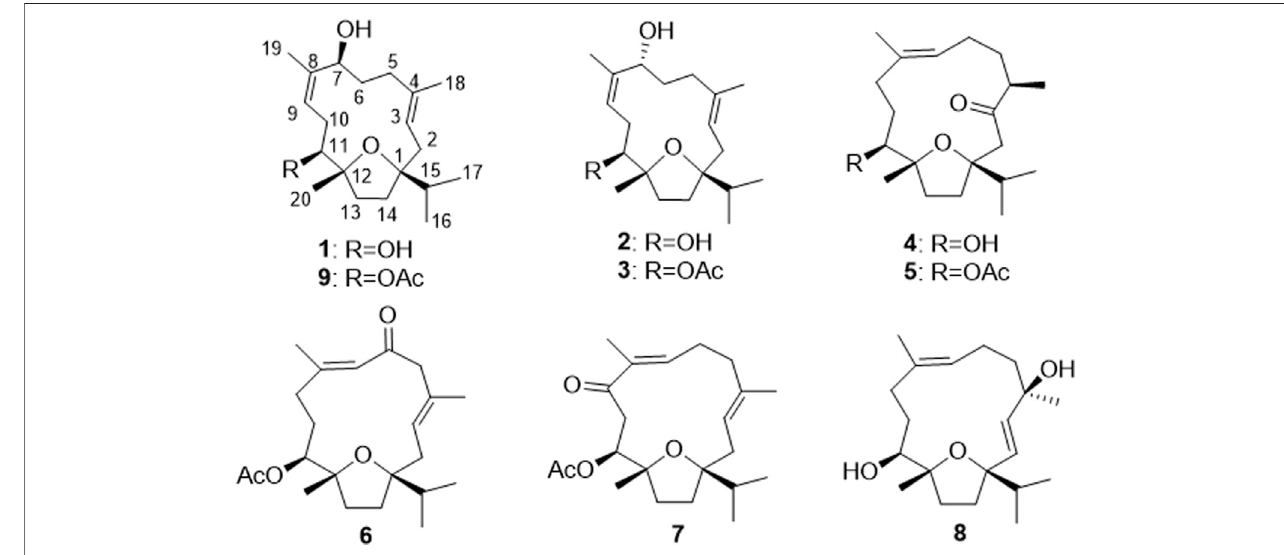
FIGURE 1 | Chemical structures of compounds 1 – 9